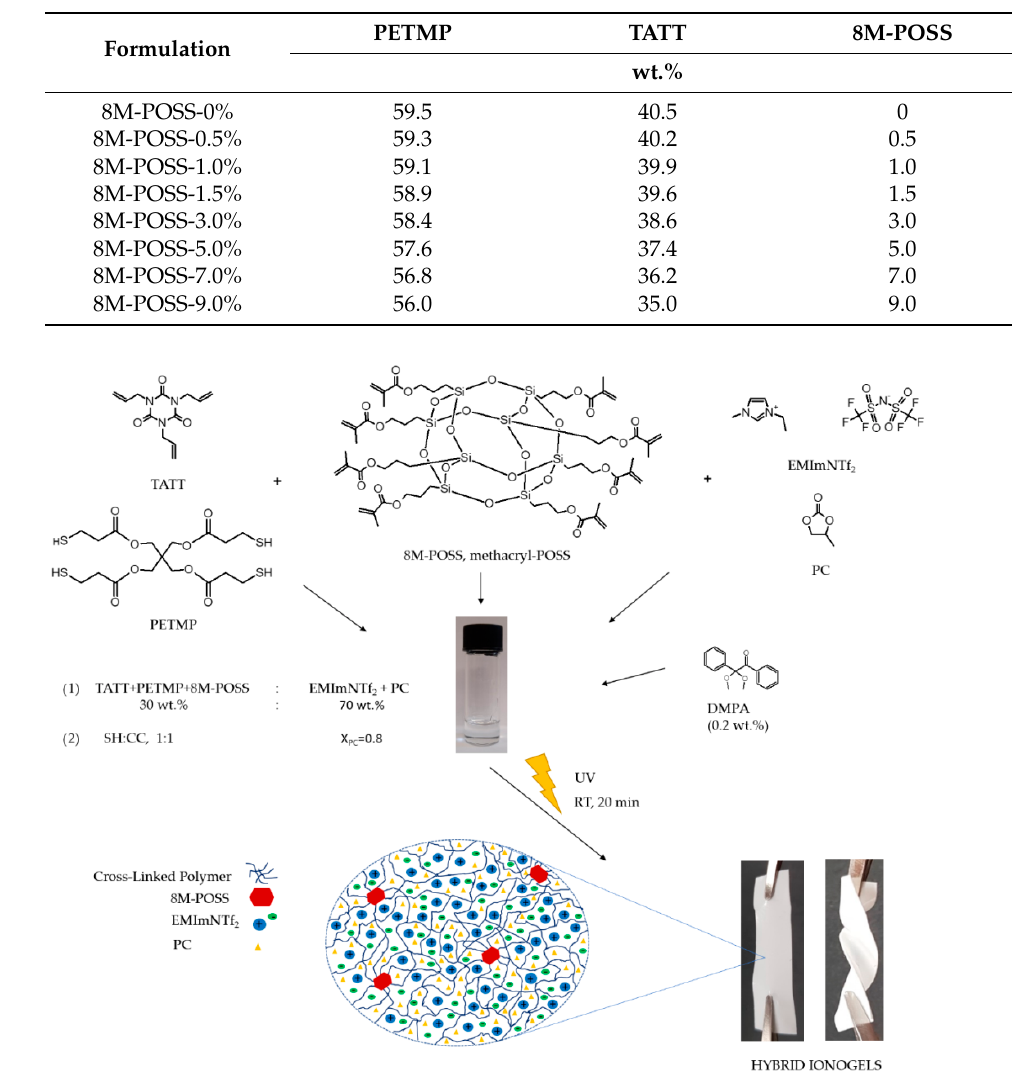
Figure 2. Schematic illustration of hybrid ionogels